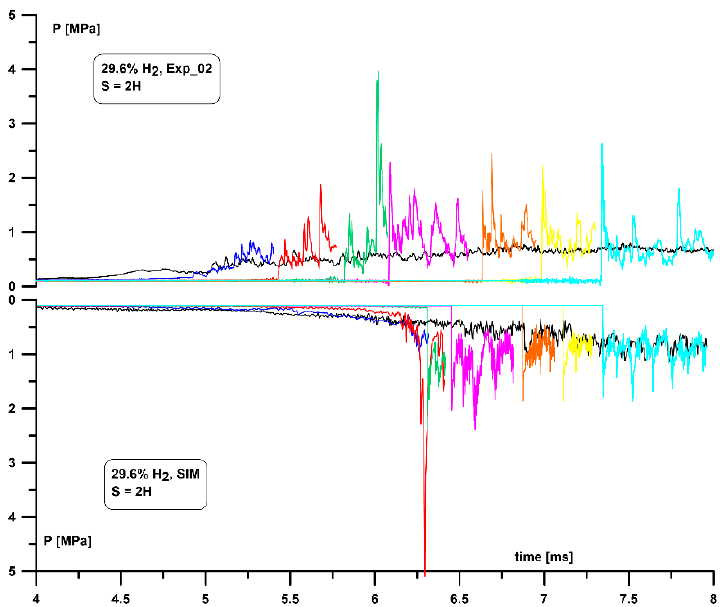
Figure 10. Experimental (top) and numerical (bottom) pressure profile with detonation for case S = 2H and 29.6% H 2 in air. The sequence of sensor activation corresponds to the sensors position as in Figure 1. Same colors apply to sensors in the same position. Simulation time shifted +1 ms for better visibility.